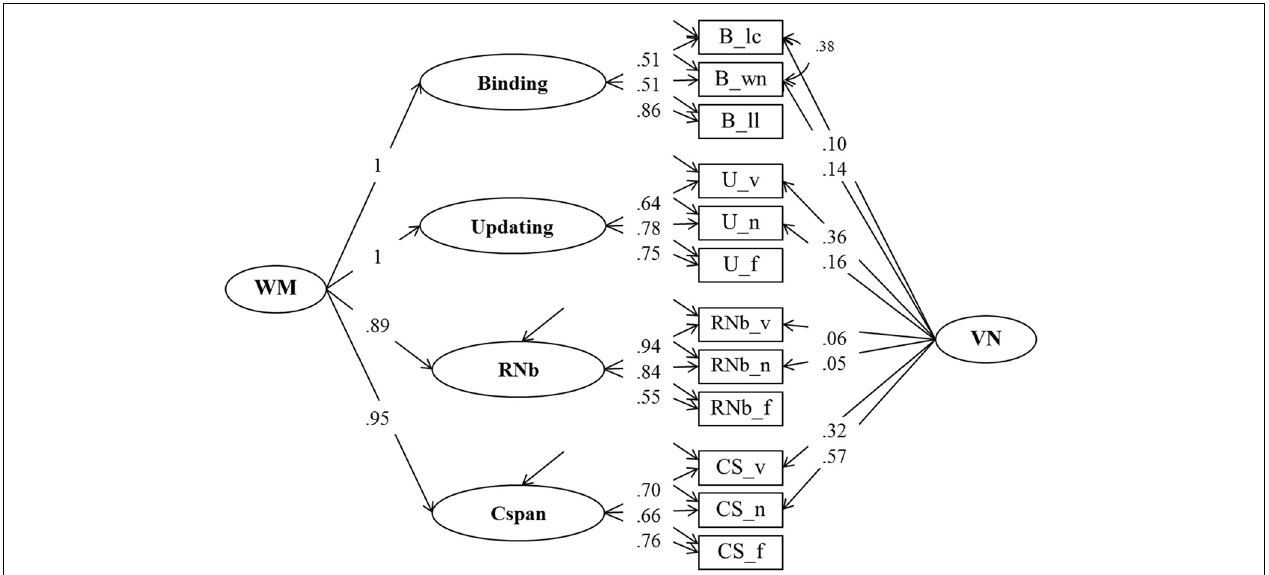
FIGURE 4 | Confirmatory factor analysis of Binding, Updating, Recall 1-back (RNb) and Complex Span (Cspan) Tasks (Model 2). The common variance of the task factors is accounted for by the higher-order Working Memory (WM) factor. The loadings of the Binding and Updating factors on